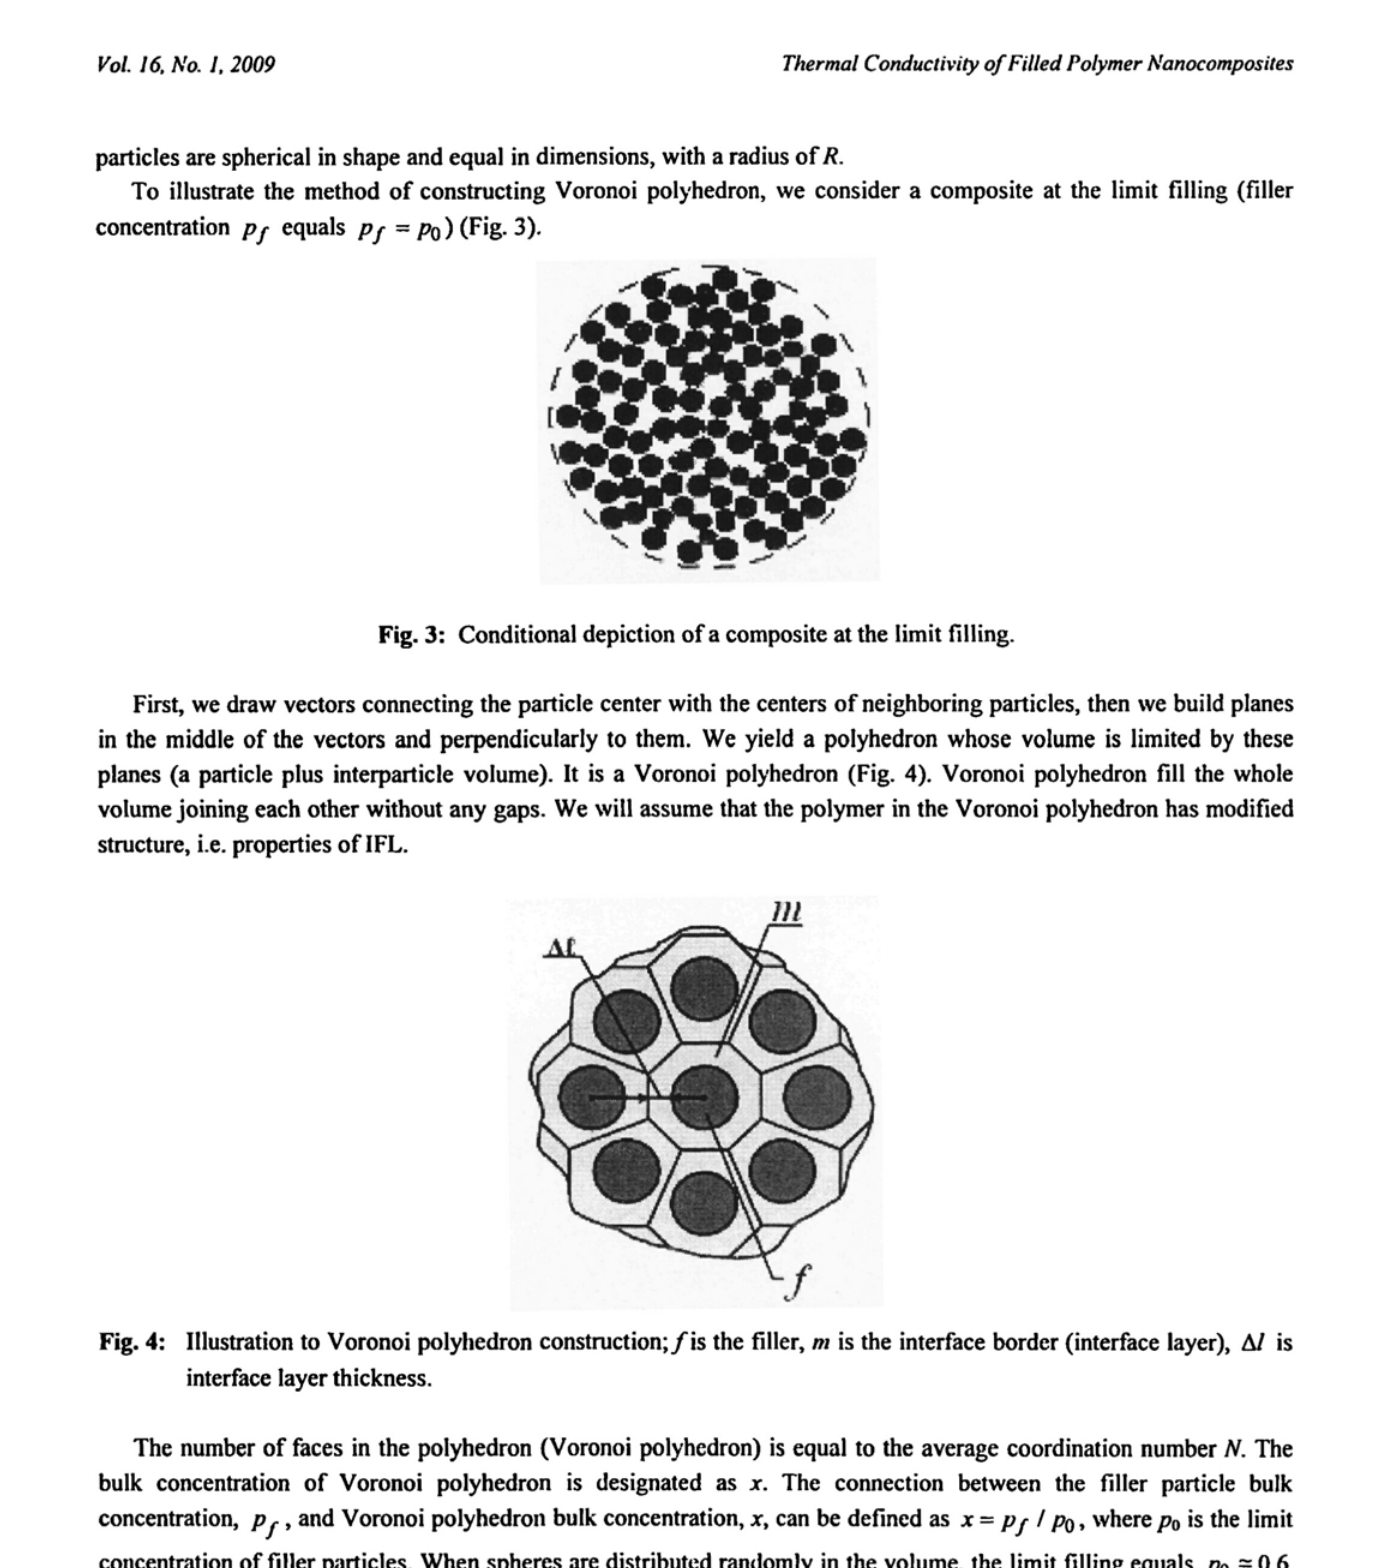
Fig. 4: Illustration to Voronoi polyhedron construction;/is the filler, m is the interface border (interface layer), Δ/ is interface layer